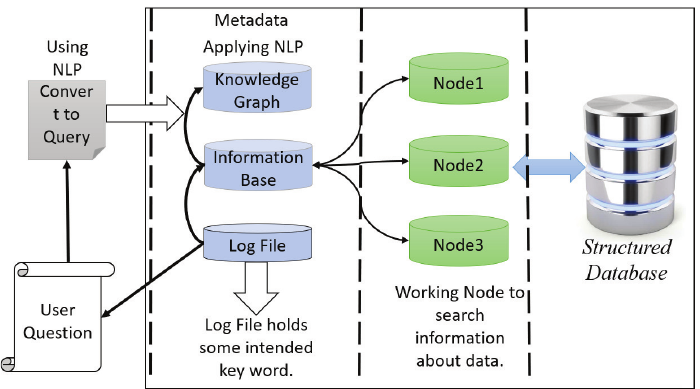
Figure 2. The data warehouse